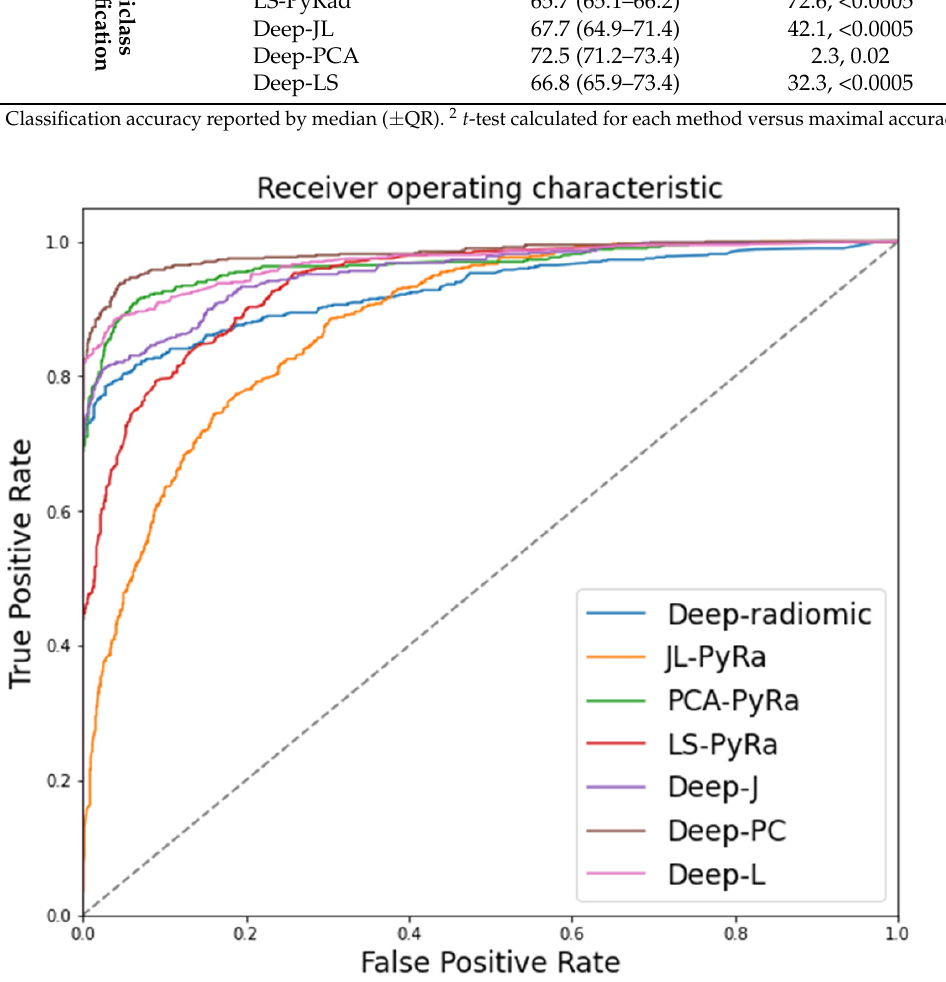
Figure 6. The receiver operating characteristic (ROC) curves for deep radiomics and compressed conventional radiomics using JL, LS, and PCA, and a combination of both deep and conventional radiomics are shown. The best multivariate binary-class classification model for COVID-19 versus non- COVID-19 (i.e., pneumonia and no-finding) cases was PCA, which resulted in an accuracy of 89.6% (88.4–90.7%), and deep-LS and deep-PCA for the combination of both